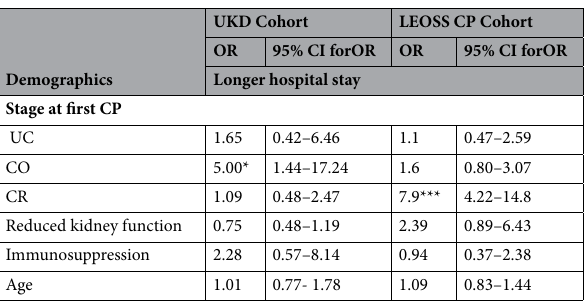
Table 4. Binary and multinomial logistic (stage at CP) regression to identify risk factors for longer hospital stay ( ≥ 14 days).